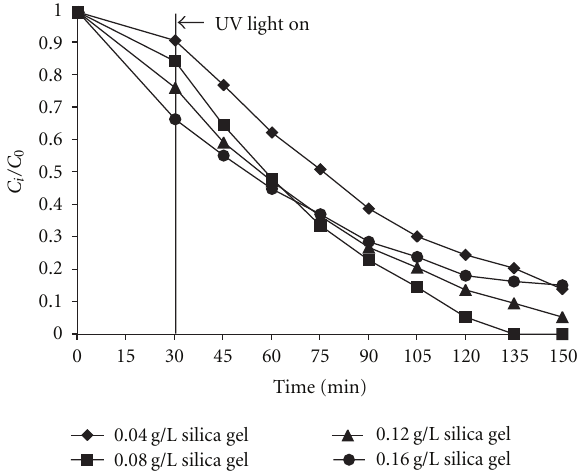
Figure 6: Photocatalytic performance of di ff erent silica gel loading in the phenol degradation. Conditions: TiO 2 nanotubes and colloidal silica in the catalyst were 0.12 and 0.80g/L, respectively, air flow rate = 0.3L/min, initial phenol concentration = 30mg/L, and medium pH = 3.